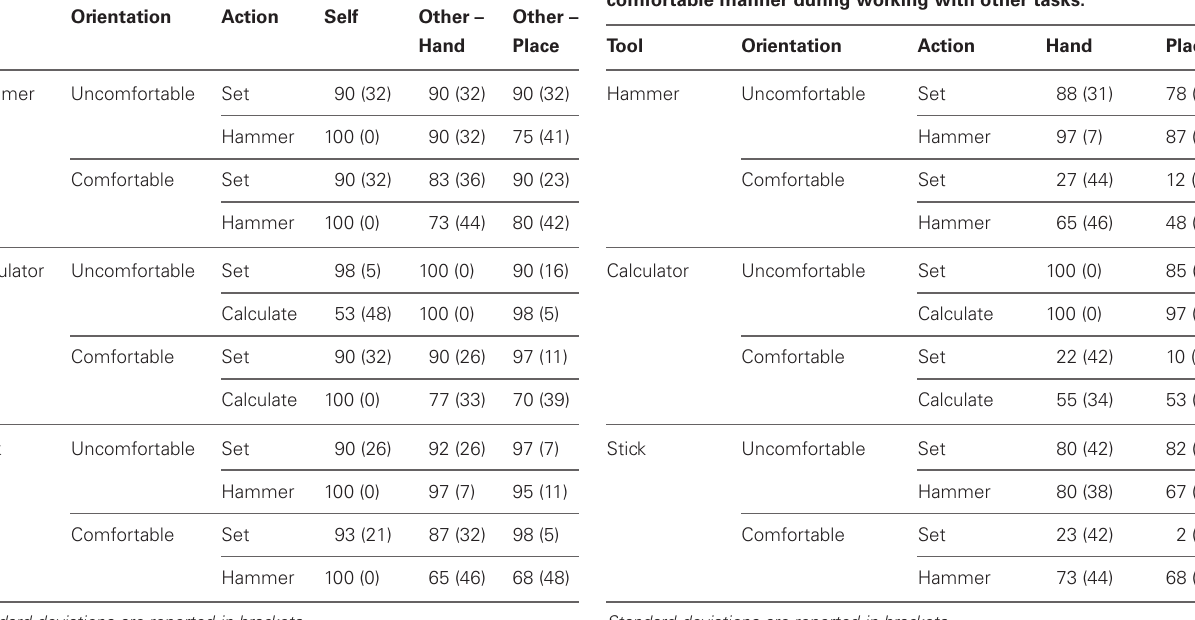
Table 5 | Percentage (%) of trials that confederate received tool in comfortable manner during working with other